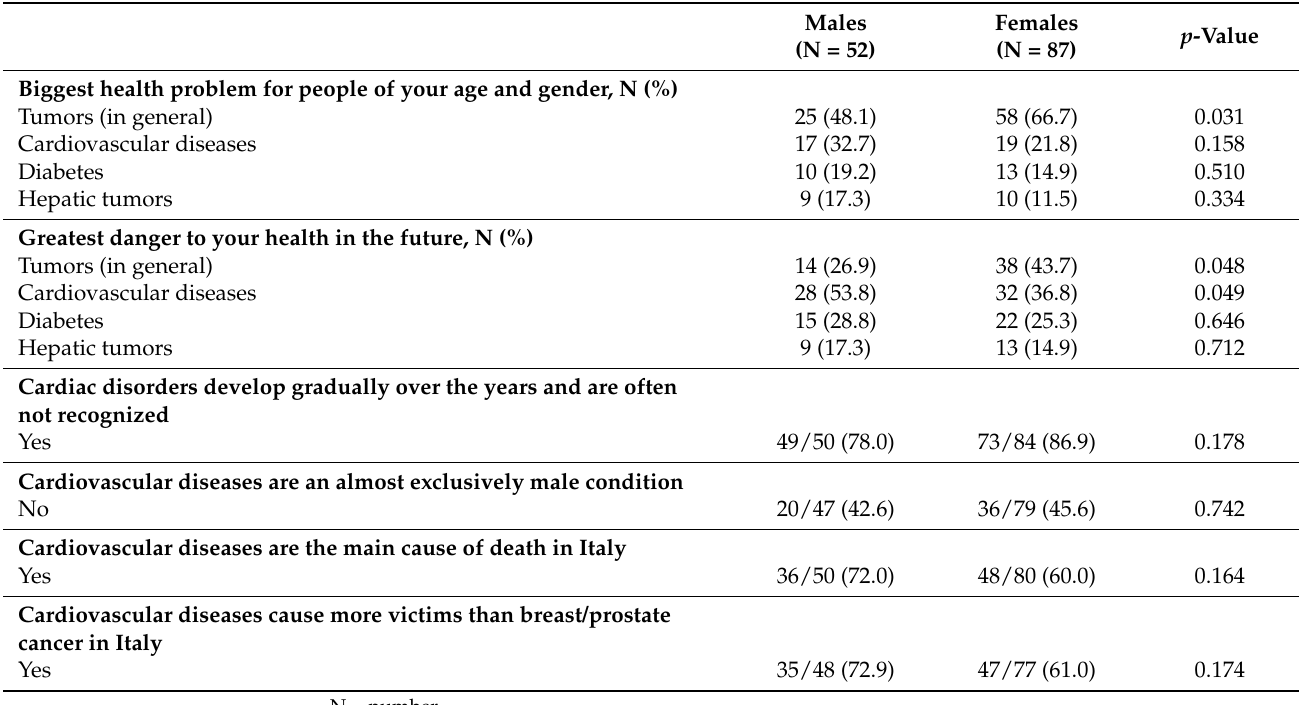
Table 2. Knowledge and awareness of CVD among Italian TM patients according to